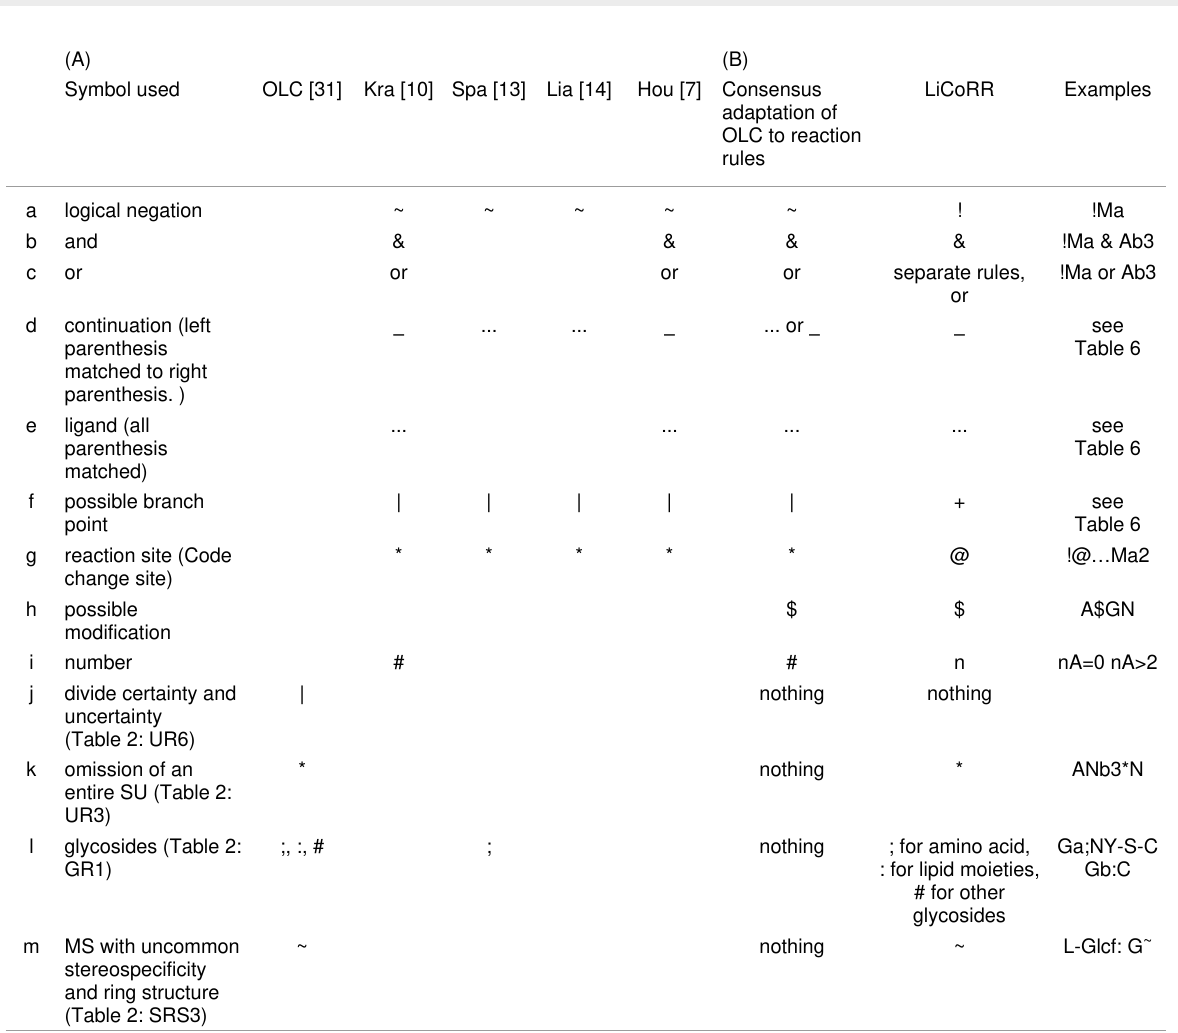
Table 10: Symbols previously used by systems glycobiologists and our recommendations. Rows a–i are the functions implemented by published papers. Rows j–m are the functions prescribed in the original Linear Code rules. (A) Symbols to represent reaction rules across publications utilizing Linear Code. (B) Consensus and recommendation for reaction rule representation going